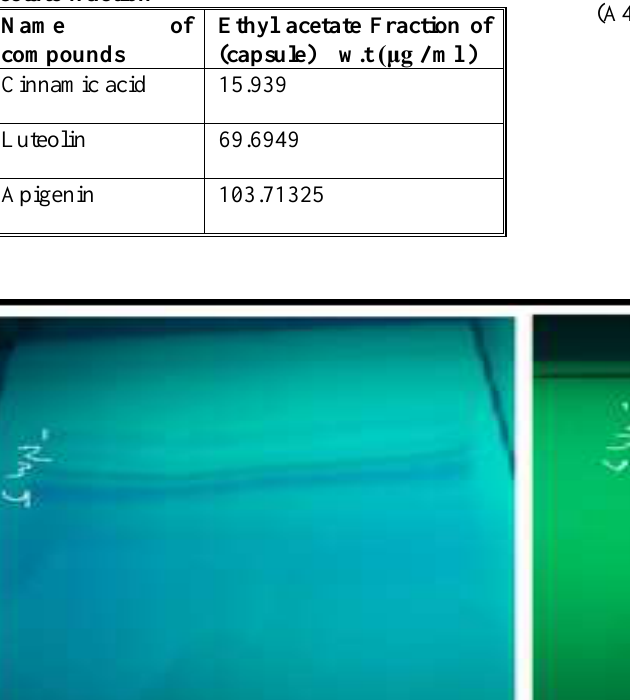
Table 5. Weight of main compounds in ethyl